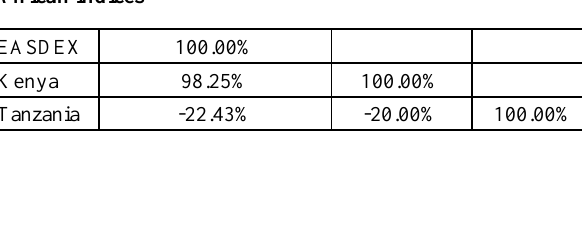
Table 6: East Africa – Historical returns of indices for 2000 EASDEX -14.06% Tanzanian index -3.18%